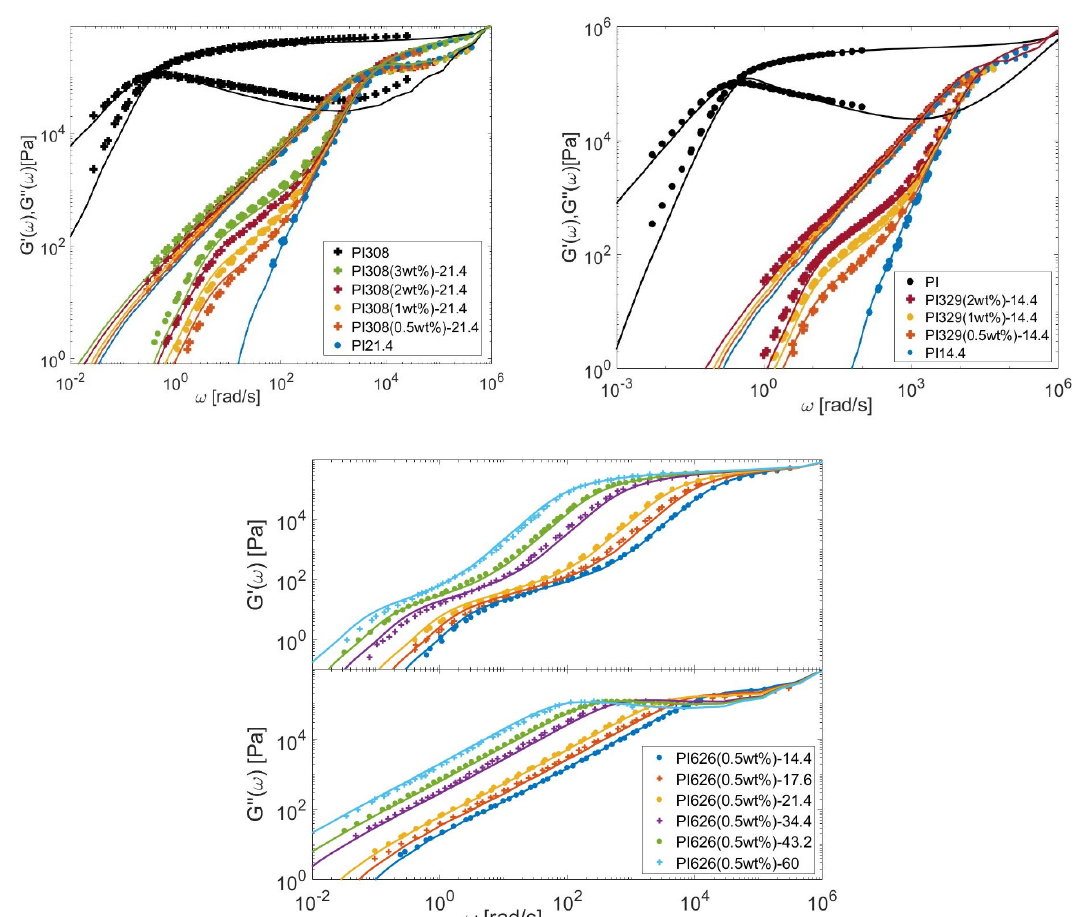
Figure 14. Comparison between predicted (continuous lines) and experimental (symbols) storage and loss moduli of the long PI chains in monodisperse state or diluted in various matrices (see Table 4).